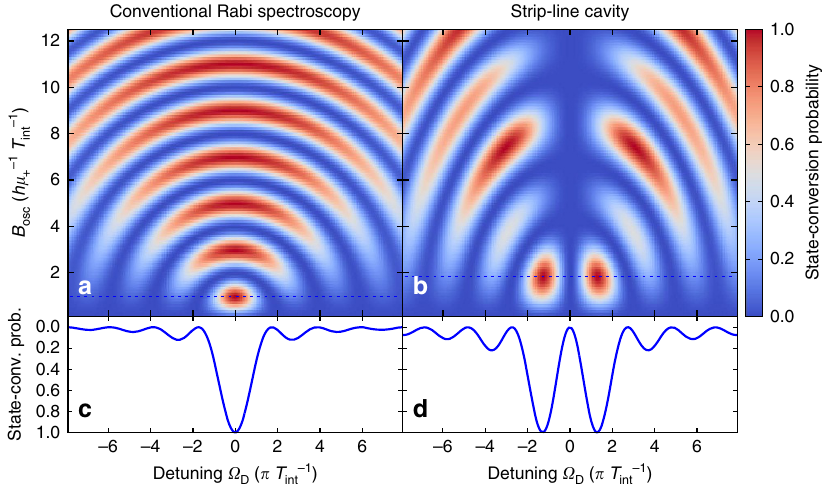
Figure 4 | State-conversion maps for driving strength and detuning. Comparison of the state-conversion probabilities as a function of the detuning O D (in units of p T (cid:3) 1 ) and the amplitude of the oscillating magnetic field B osc (in units of h m (cid:3) 1 int when using a strip-line cavity ( b ) to drive the transition. Both cases refer to a monoenergetic beam, which translates to a fixed interaction time T int . The dashed horizontal line indicates the required driving strength to reach the first complete state conversion. The plots ( c , d ) are projections of the state-conversion probabilities at the dashed lines and show the ideal (that is, monoenergetic) line shapes observed as count rate drops in the Rabi